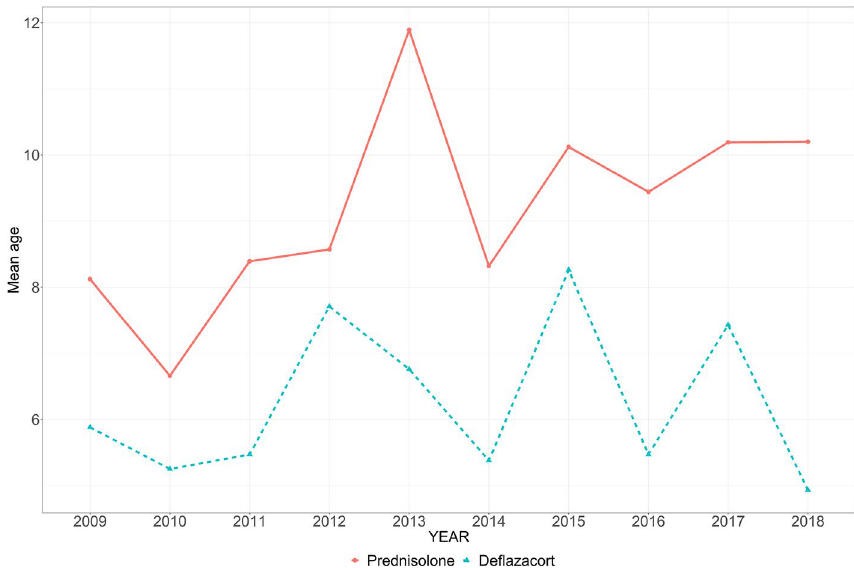
Figure 4. Mean age of patients prescribed corticosteroids in